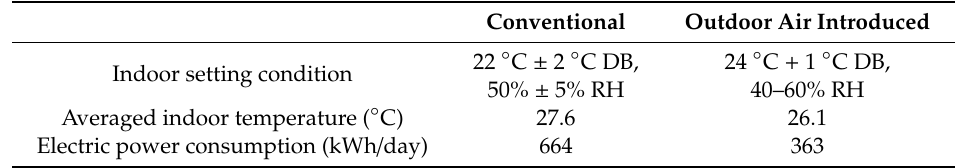
Table 4. Comparison of the indoor conditions and daily electric power consumption of the conventional and the proposed cooling method.